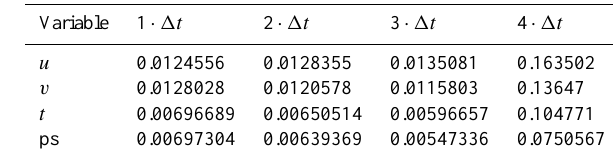
Table 1. Relative mean